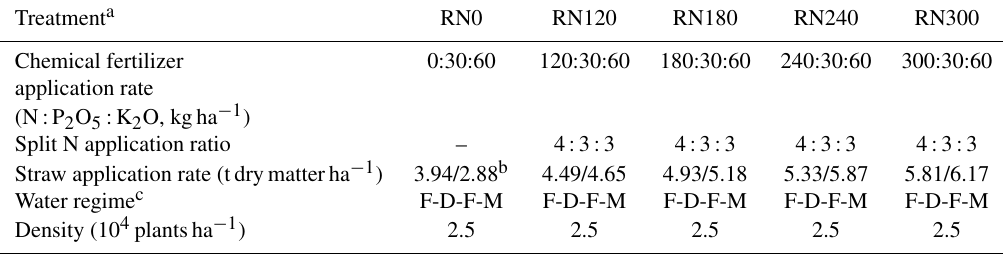
Table 1. Field experimental treatments and agricultural management practices during the rice-growing seasons of 2013 and 2014 in the Taihu Lake region. Treatment a RN0